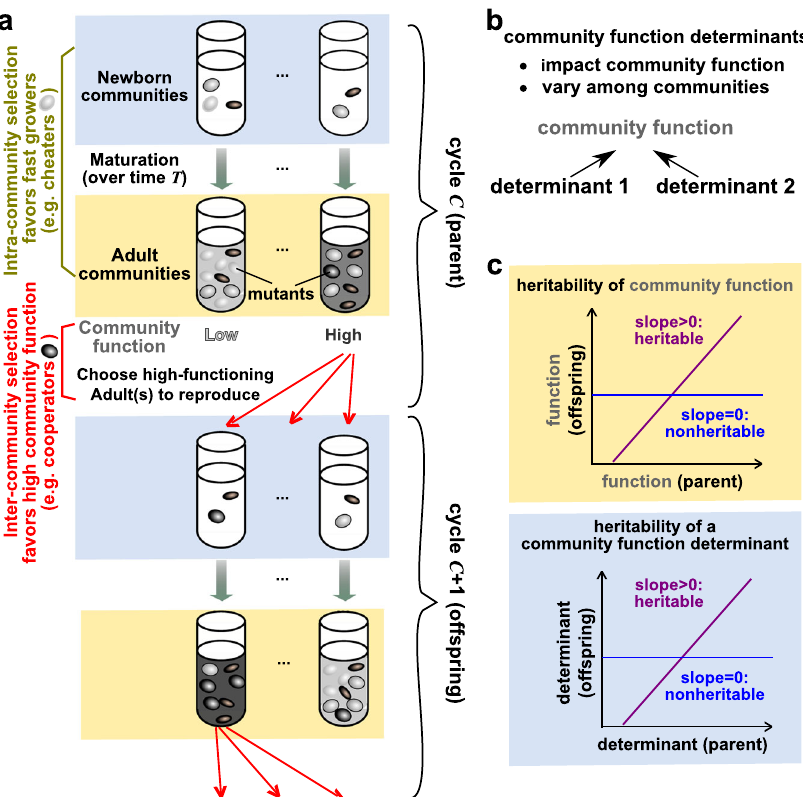
Fig. 1 Arti fi cial community selection to improve a community function. a Arti fi cial community selection. In each cycle, Newborns (blue shading) mature into Adults (yellow shading) during which intracommunity selection favors fast growers (olive bracket). The highest-functioning Adults are then chosen to reproduce, and this intercommunity selection favors high function (red bracket). Note that both parent (top half) and offspring (bottom half) communities have Newborn and Adult stages. Thus, the four rows from top to bottom represent parent Newborn, parent Adult, offspring Newborn, and offspring Adult, respectively. b Community function determinants. c Heritability of community function and community function determinants. Similar to how heritability of individual-level trait is determined 60 , we estimate heritability of community function (top) and of community function determinants (bottom) from the slope of linear regression between parent functions (or determinants) and offspring functions (or determinants). Thus, although the notion of heritable versus nonheritable is convenient for conceptualization, heritability is